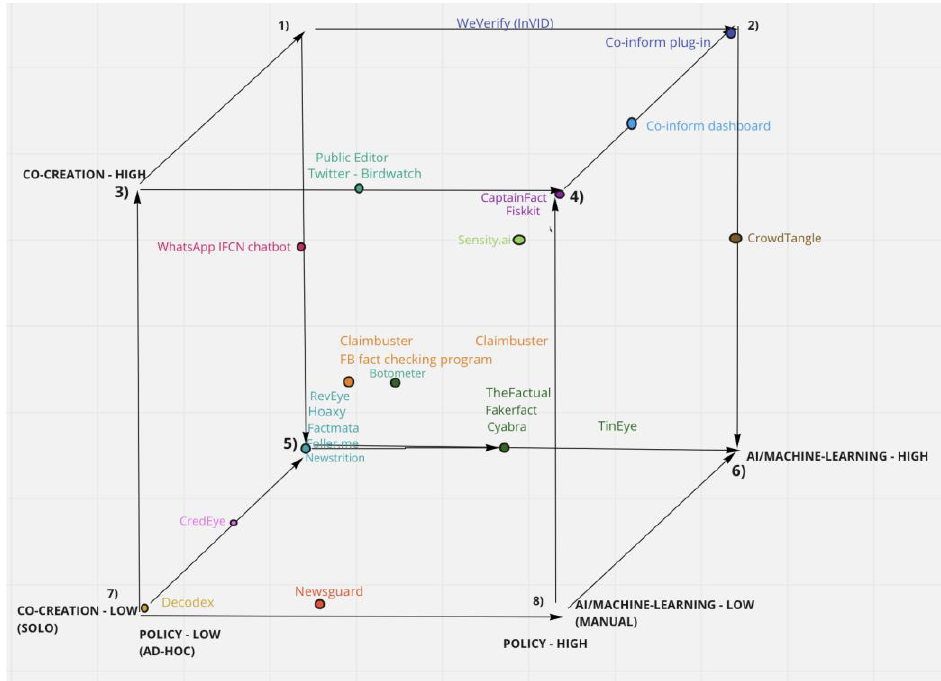
Figure 2 Distribution of the mapped tools across the